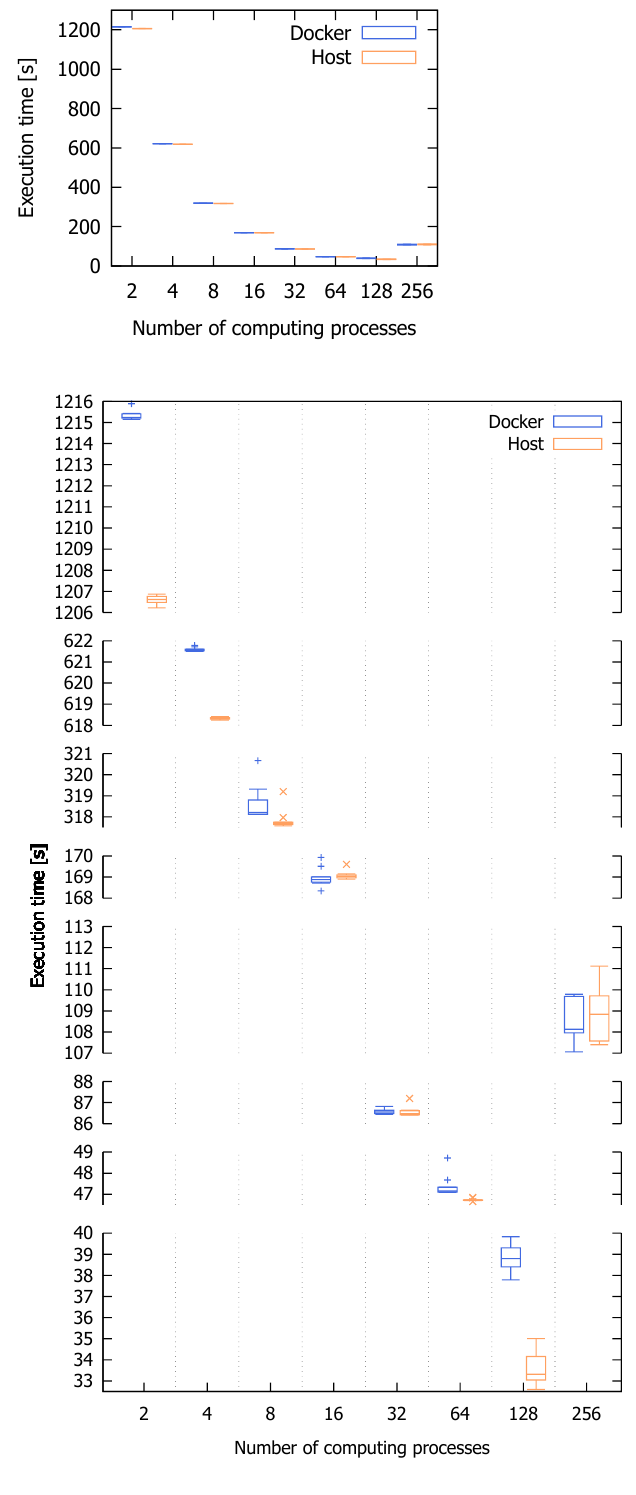
Figure 7. Execution times for SPMD, -O2 compilation flag; boxplot notation: medians, Q1 and Q3, max(Q1 − 1.5IQR, minimum) and min(Q3+1.5IQR, maximum) as well as potential outliers (+ for Docker, x for